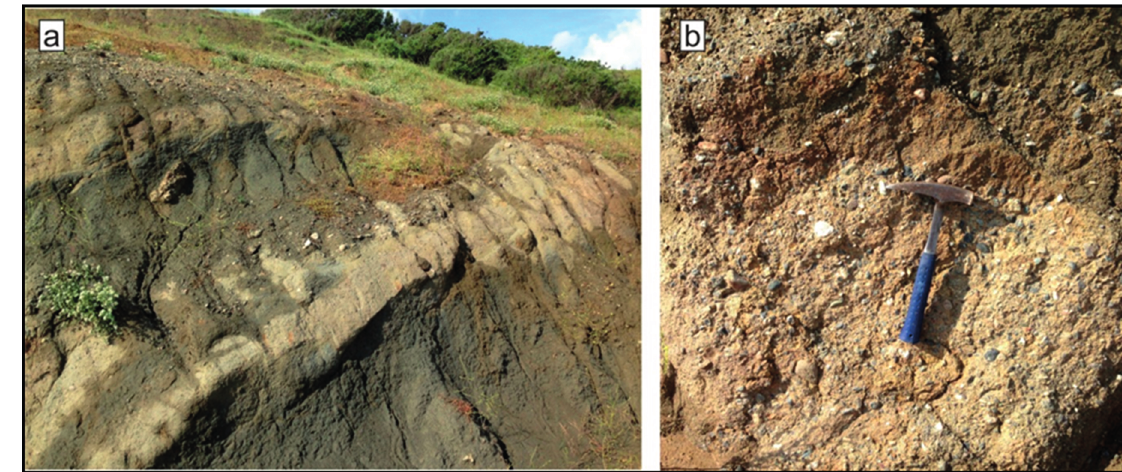
Figure 3. ( a ) The sandstone and conglomerate of the F ı ç ı tepe Formation; and ( b )